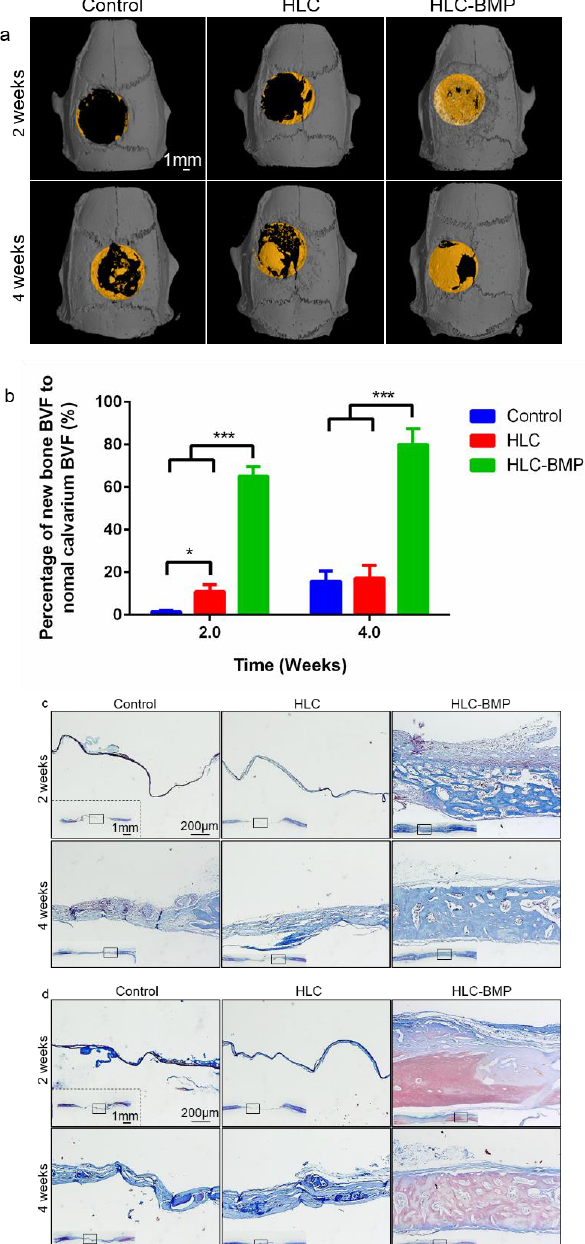
Figure 6. Micro-CT and histological evaluation of the rat cranial defect repair after 2-and 4-weeks implantation. ( a ) Representative micro-CT images of implants (HLC and HLC-BMP) ( b ) Quantitative analysis of bone formation in each group ( * p < 0.05, *** p < 0.001, n = 3). Implant histological evaluations on sections stained with ( c ) MTS and ( d ) Ponceau’s stain for the control, HLC and HLC-BMP group, respectively.